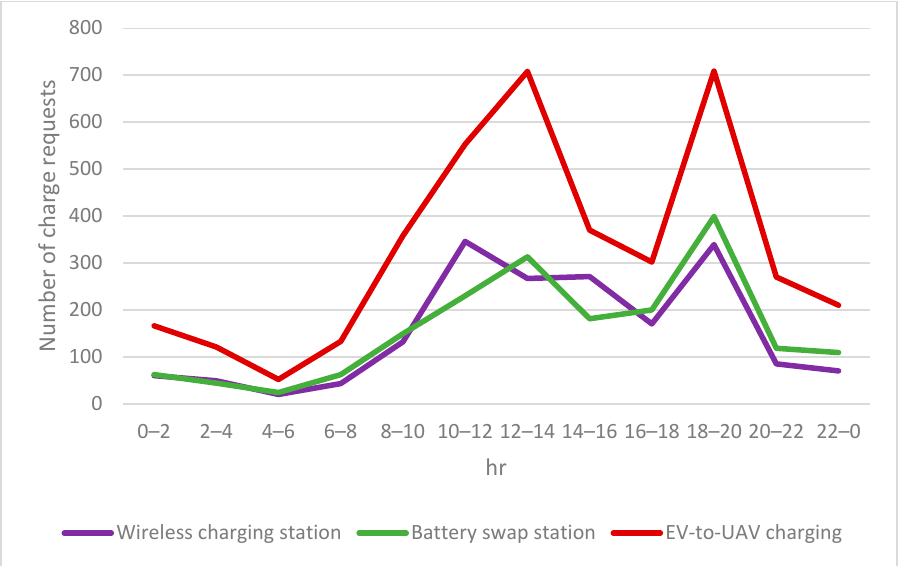
Figure 8. Number of charging requests for emergency missions.